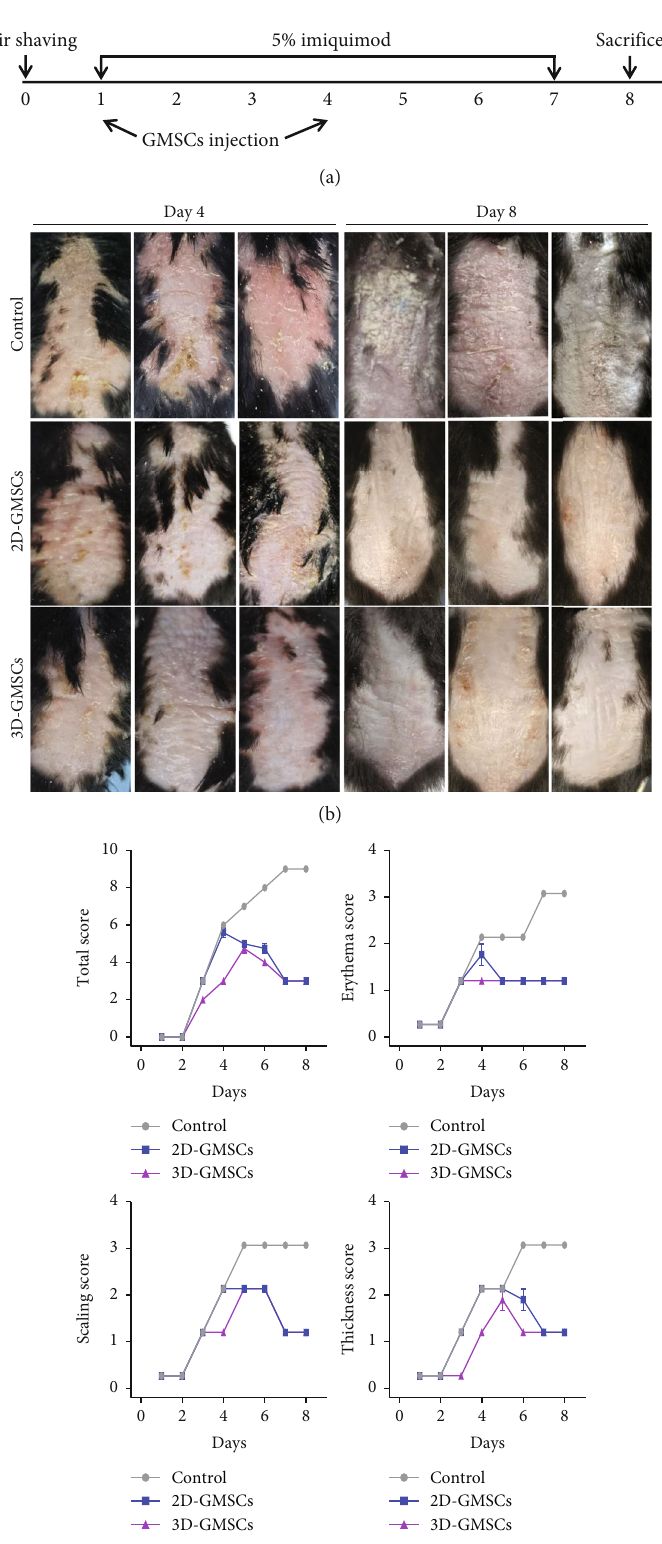
Figure 3: 2D-GMSCs and 3D-GMSCs signi fi cantly ameliorated psoriatic symptoms in IMQ-induced mice. MSC infusion ameliorated psoriatic symptoms in IMQ-induced mice. (a) Experimental protocol showing treatment regimens using 2D-GMSCs and 3D-GMSCs in psoriatic mice. (b) Typical presentation of the mouse back skin from IMQ, 2D-GMSCs, and 3D-GMSCs group on day 4 and day 8 was, respectively, shown. (c) Di ff erent levels of erythema, scales, thickness of back skin, and total score were scored